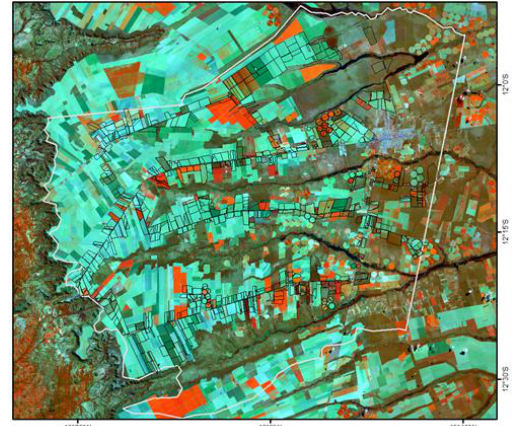
Figure 1. Sentinel-2/MSI image (from 20th April 2018) from LEM (white line corresponds to the limit of the municipality) in false-colour composition (RGB – NIR SWIR Red). The 794 crop field boundaries of LEM database are delimited in black.